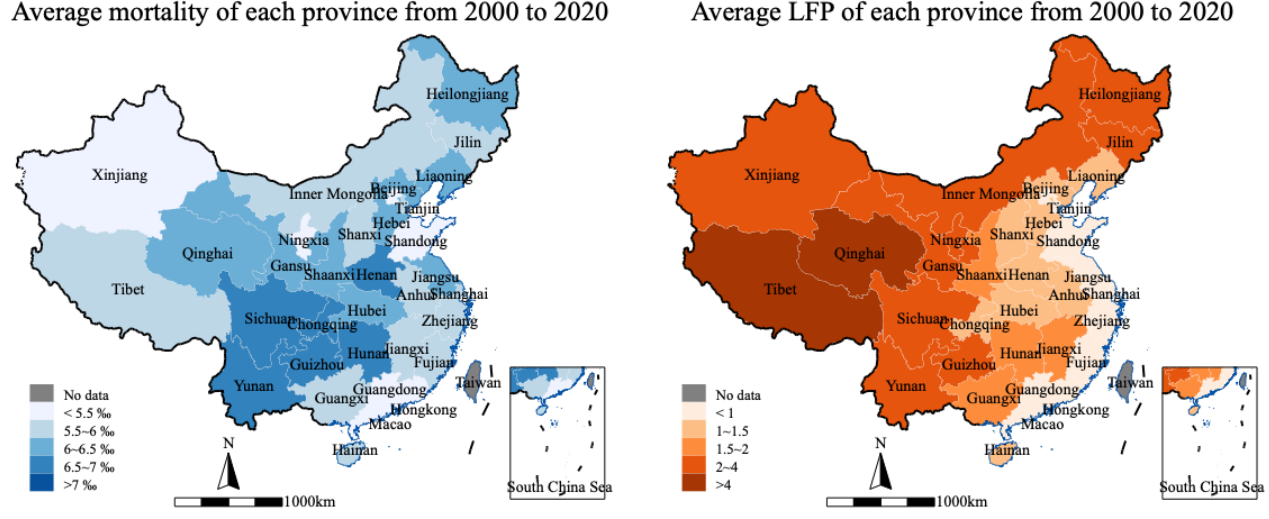
Figure 4. Average provincial differences from 2000 to 2020. (Source: China Statistical Yearbook (2001–2021) and China Finance Yearbook (2001–2021)).